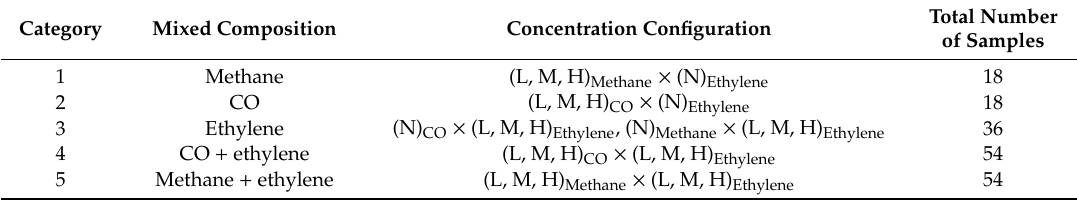
Table 7. Gas concentration configuration and number of samples for each category.